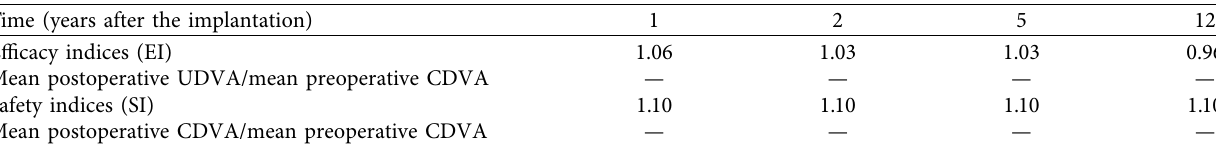
Figure 1: Cumulative distance visual acuity. Table 4: Efficacy and safety